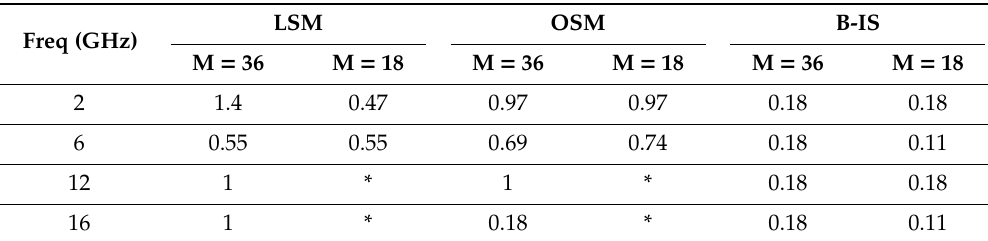
Table 2. Dimensional errors for the DielTM target. LSM and OSM indicators were binarized by applying the Canny edge detector. The symbol * indicates the cases wherein the indicator maps were not reliable, and the dimensional error was not computed.